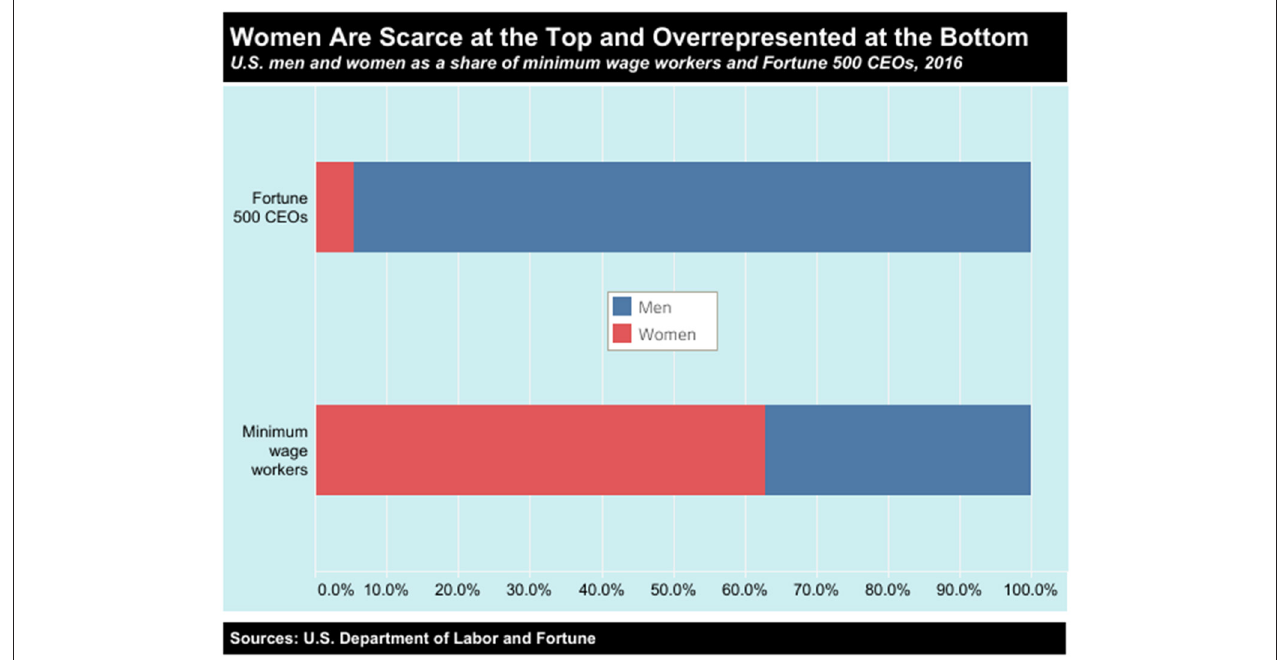
FIGURE 3 | Women are under represented at the top of the wealth pyramid and over represented at the bottom, occupying the lowest paid jobs in society, according to the United States Department of Labor